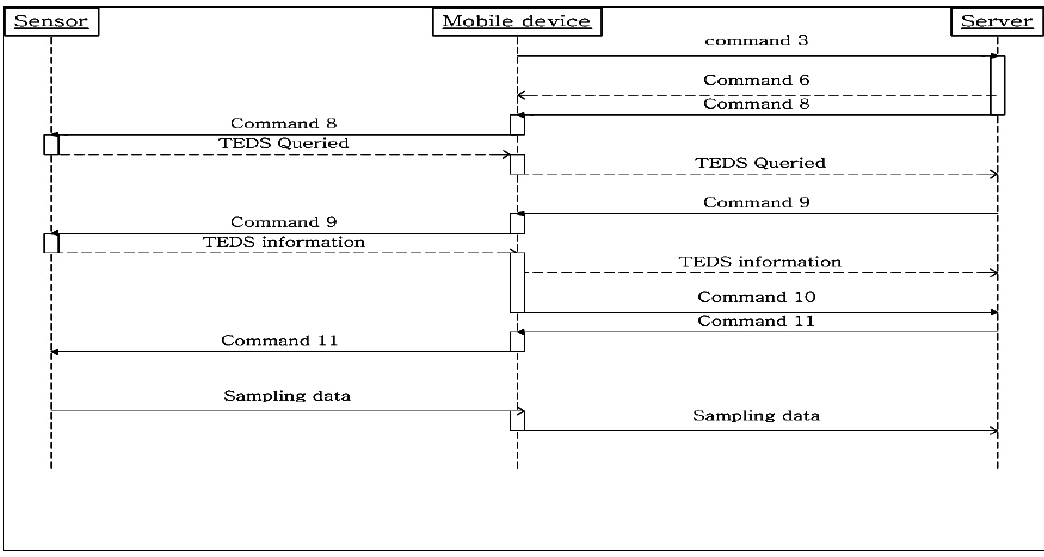
Figure 7. The protocol between the sensor, mobile device and server.